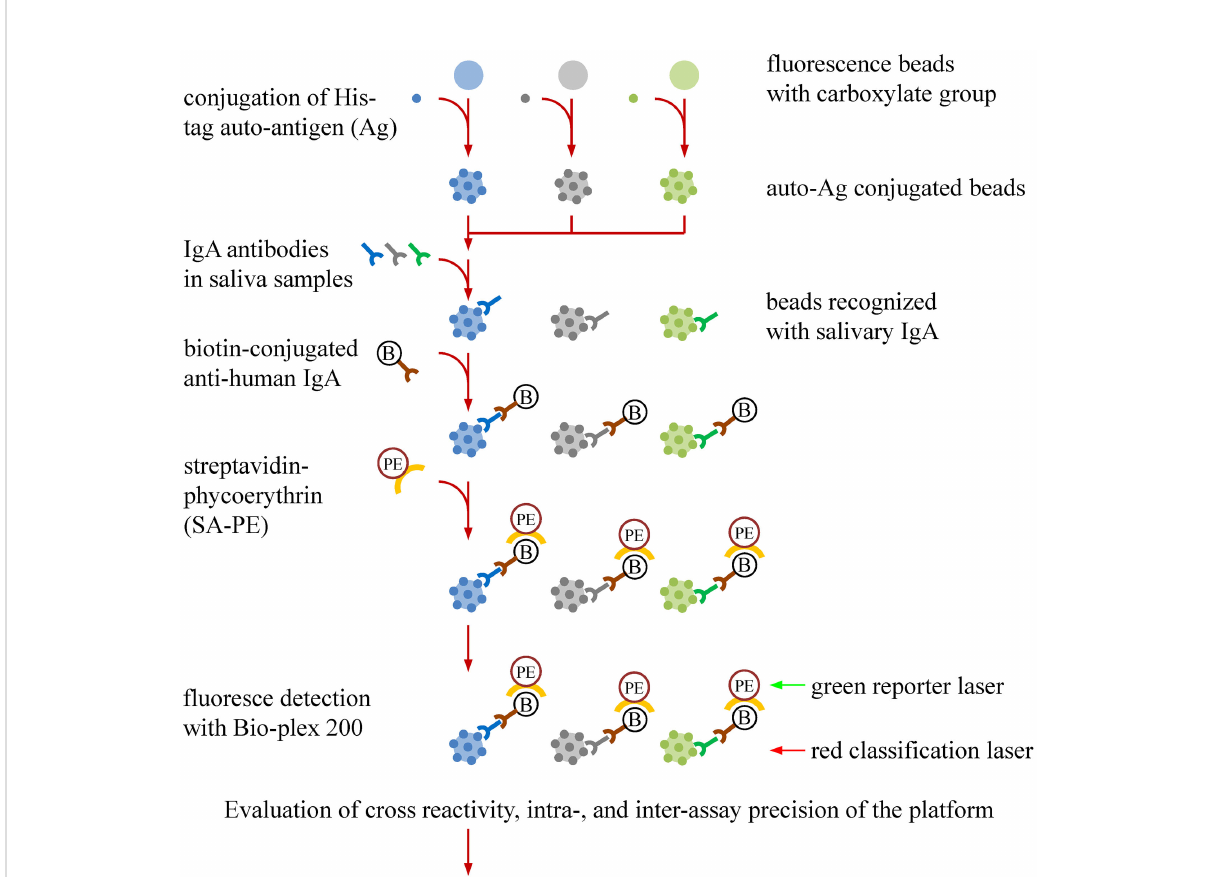
FIGURE 1 Work fl ow for establishment of a bead-based suspension immunoassay for auto-Ab detection in saliva samples. Auto-Ab detection was conducted with a multiplexed bead-based suspension array system (Bio-Plex). To generate the beads used in the system, individual His-tagged recombinant protein were covalently conjugated to the COOH beads with an unique fl uorescent identity. The resulting recombinant protein- conjugated beads can capture the salivary IgA speci fi cally responsive to the recombinant proteins. By addition of a biotin-labeled anti-human IgA and streptavidin-phycoerythrin (SA-PE), the levels and identities of salivary IgA auto-Abs can be simultaneously investigated in the Bio-Plex system, in which the “ red ” laser is applied to interrogate the bead identity which identi fi es the auto-Ab type, and the “ green ” laser is used to assess the level of the identi fi ed auto-Abs. An anti-His Ab is used to evaluate the protein-coupling ef fi ciency, the cross-reactivity of the beads, and the precision of the multiplex